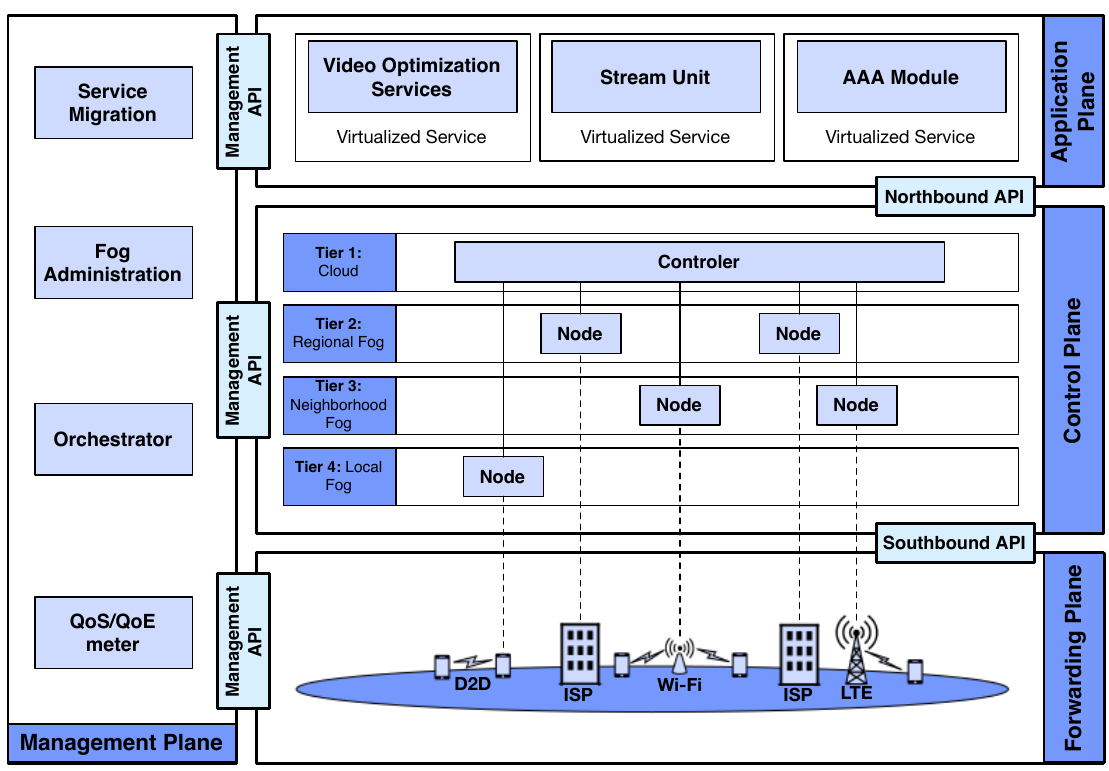
Figure 1. Multi-tier Fog